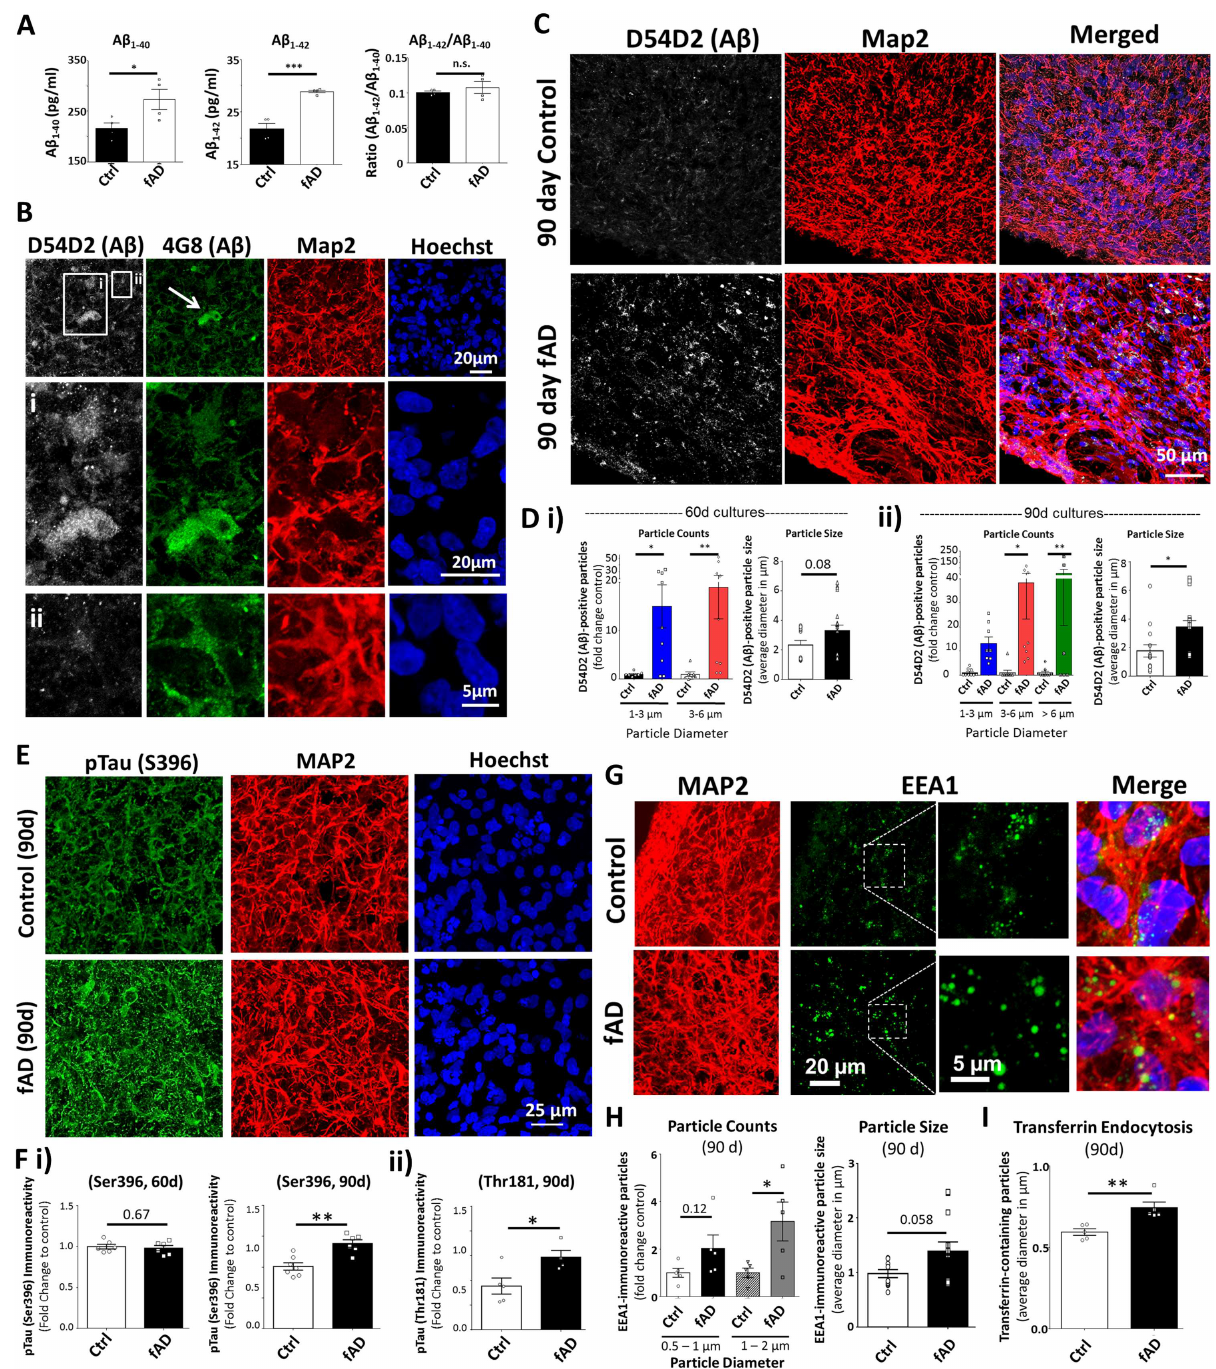
Fig 1. Organoids createdfrom patient-derivediPSCs exhibitrobust Alzheimer’s disease(AD)-likepathology. (A) Concentration of A β 1–40 and A β 1–42 fromsupernatantof control (Ctrl;CS-0020-01) and familial AD (fAD; APP Dp 1-1)organoidcultures,measuredby ELISA, as well as the ratio of A β 1–42 to A β 1–40 concentrations. Unpairedtwo-tailedt-testwith equal variance: * p = 0.047 (A β 1–40 ), unpaired two- tailed t-testwith Welch’s correction for unequalvariance: ** p = 0.004(A β 1–42 ), p = 0.48 (A β 1-42 /A β 1–40 ). (B) Tissue sectionsfromfAD ( APP Dp 1-1)and control(Ctrl;CS-0020-01) organoids were processedfor immunoreactivity againstamyloid β (A β ) using two antibodies (D54D2:white, 4G8:green),as well as antibodiesagainstthe neuronal markerMAP2 (red)and stainedwith the nuclear dye Hoechst(blue). Insets demonstrate A β immunoreactivitythat appearsboth extracellular (i, arrow)and intracellular (ii, arrowhead)based upon MAP2 co- localization. (C) Z-projection of immunolabeledtissue sections from90 day old Ctrland fAD organoidsshowing immunoreactivityfor A β